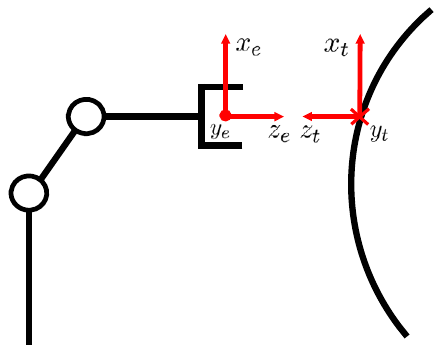
Fig. 3. End-effector and task